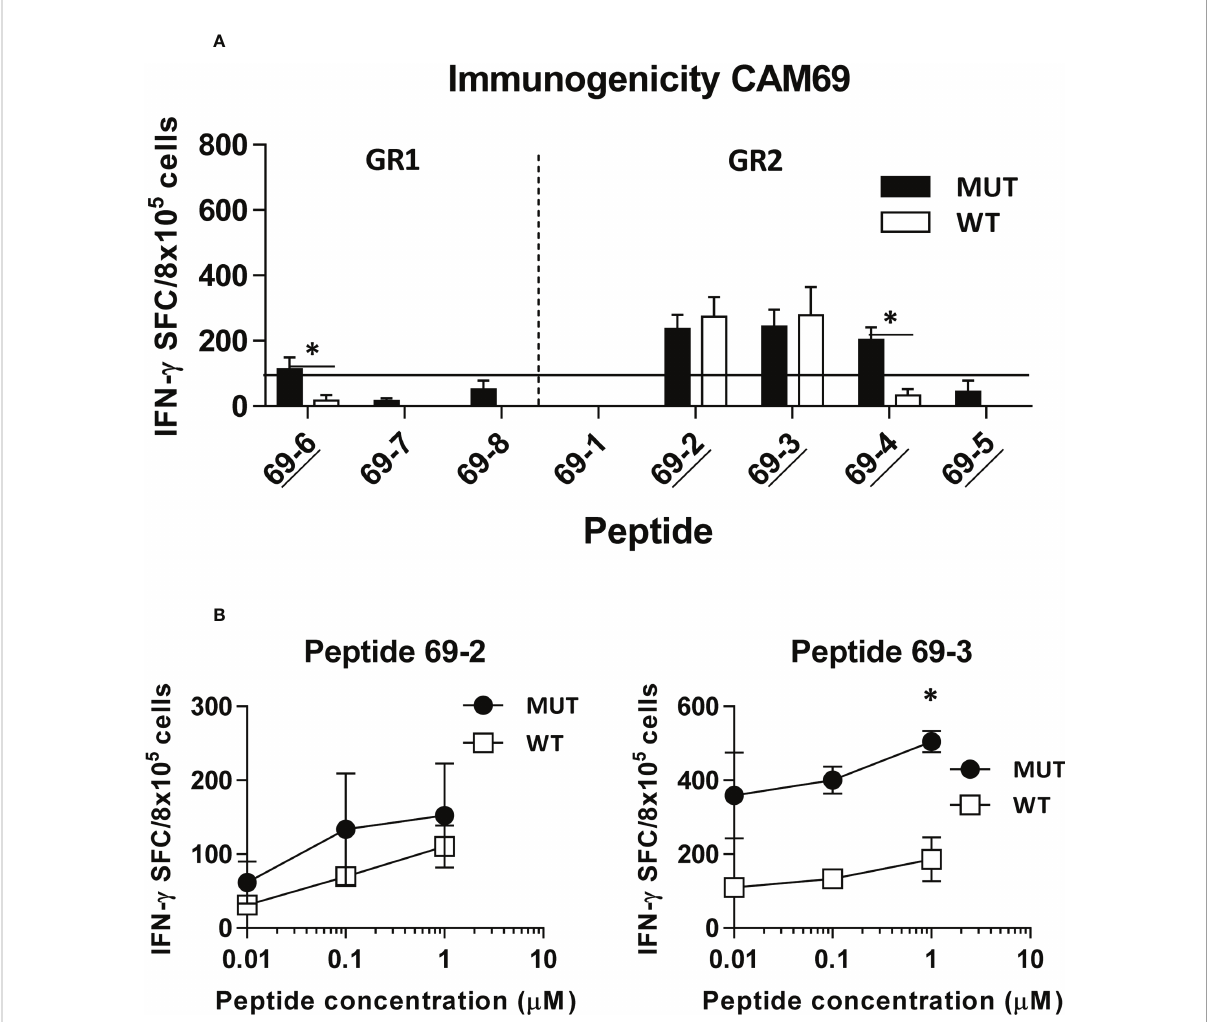
FIGURE 2 In vivo immunogenicity of predicted peptide epitopes from patient CAM69. HHD-DR1 mice (n=4/group) were immunized with peptide pools (4 peptides/pool; 100 nanomoles of each peptide/pool) plus poly(I:C) and antiCD40 adjuvants at days 0 and 7. One week after the boost they were sacri fi ced and splenocytes were stimulated with individual peptides (either mutated or WT version at 10 m M) (A) and response evaluated by using an IFN-gamma ELISPOT assay. Responses were considered positive when SFC > 50. Results correspond to the sum of 2-3 independent experiments. Peptides experimentally proven as binders are underlined. (B) Lymphocytes showing positive recognition of the WT version were titrated with lower peptide concentrations. (*P<0.05; MUT vs WT